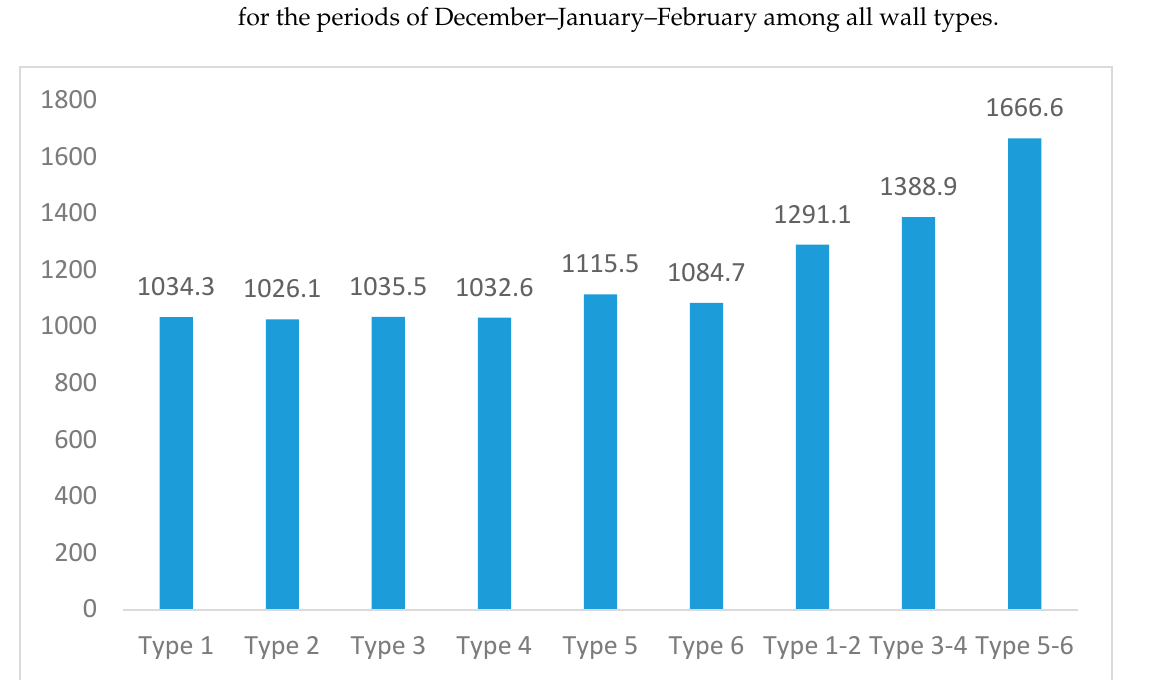
Figure 11. The energy use intensity values of the designed building types with insulation material and without insulation material.